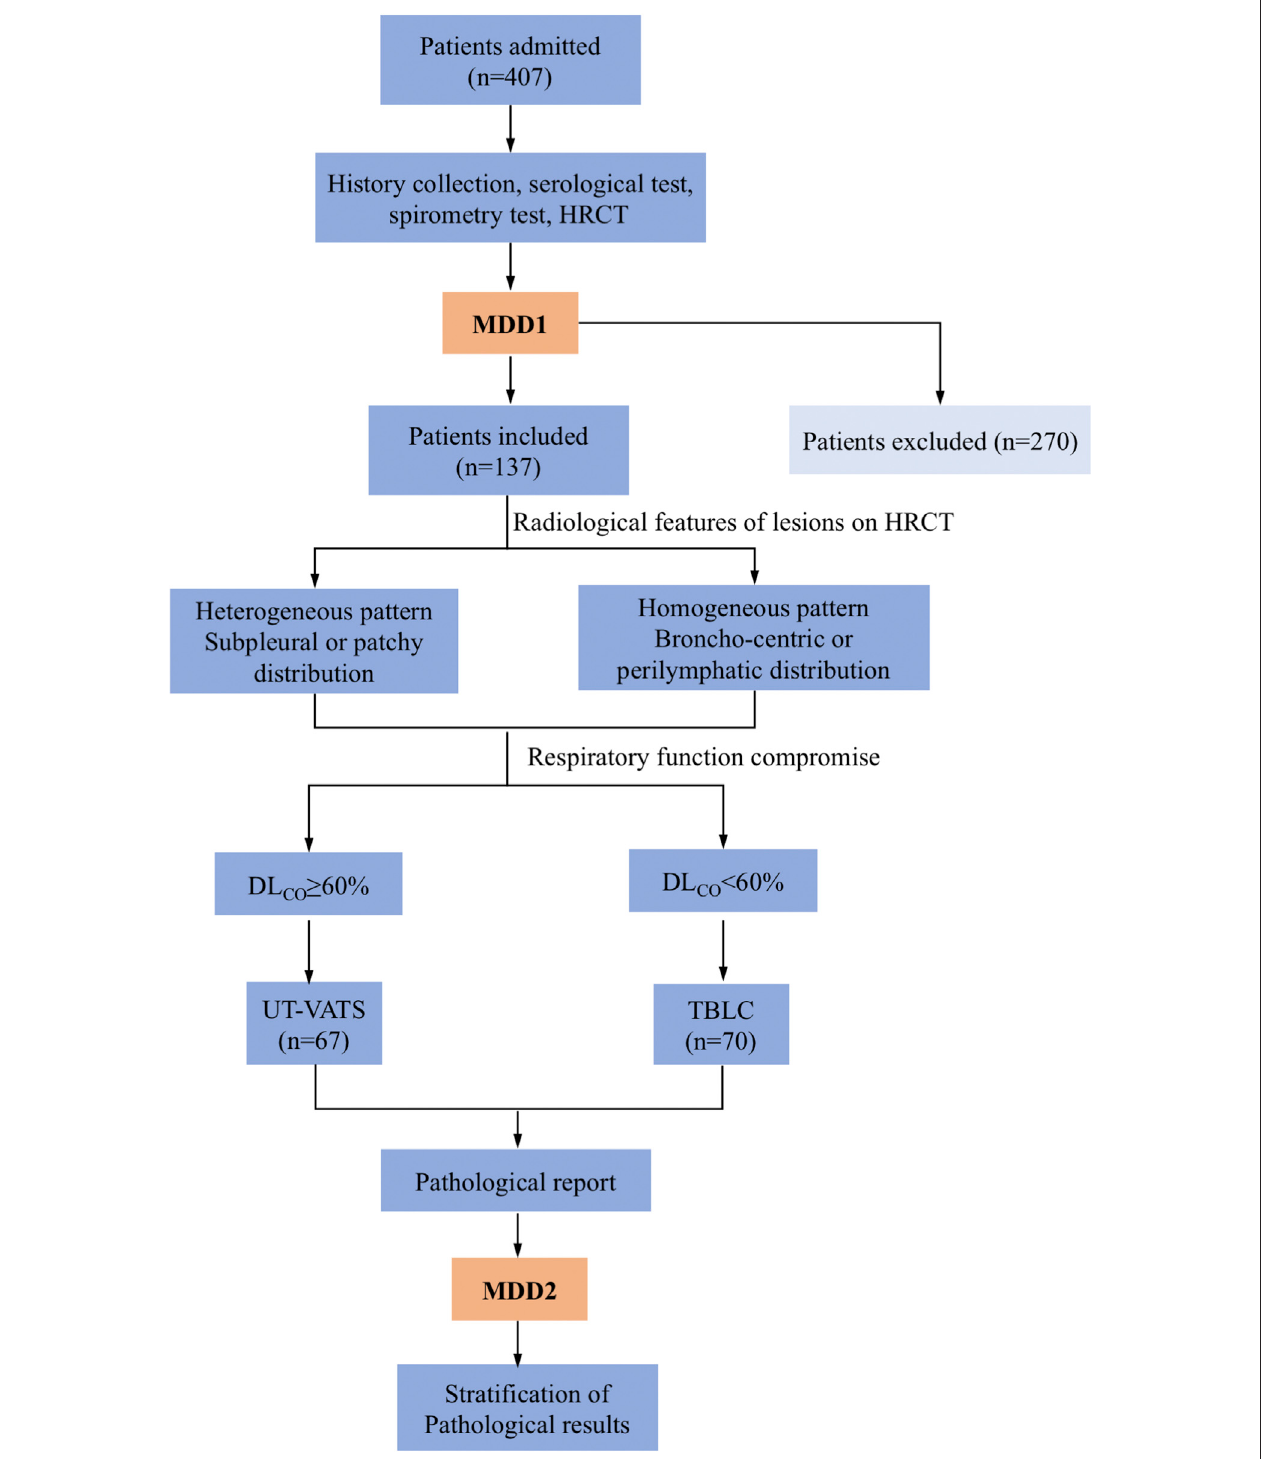
FIGURE1| Flowchartofthestudy.PatientsadmittedtotheinstituteunderwentMDD1afterhistorycollection,serologicaltesting,spirometryandHRCT.Adecision was made whether to perform a biopsy and which method (UT-VATS or TBLC) to utilize, the latter based on radiological features of lesions as well as respiratory compromise of patients. MDD2 was held with pathological reports available. Strati fi cation of pathological results was performed based on speci fi city as well as their contributiontothe fi nalMDDdiagnosis.MDD:multidisciplinarydiscussion,HRCT:highresolutioncomputed tomography.UT-VATS:uniportaland tubeless-video- assisted thoracic surgery, TBLC: transbronchial lung cryobiopsy, FVC: forced vital capacity, DL CO : carbon-monoxide diffusion coef fi cient.